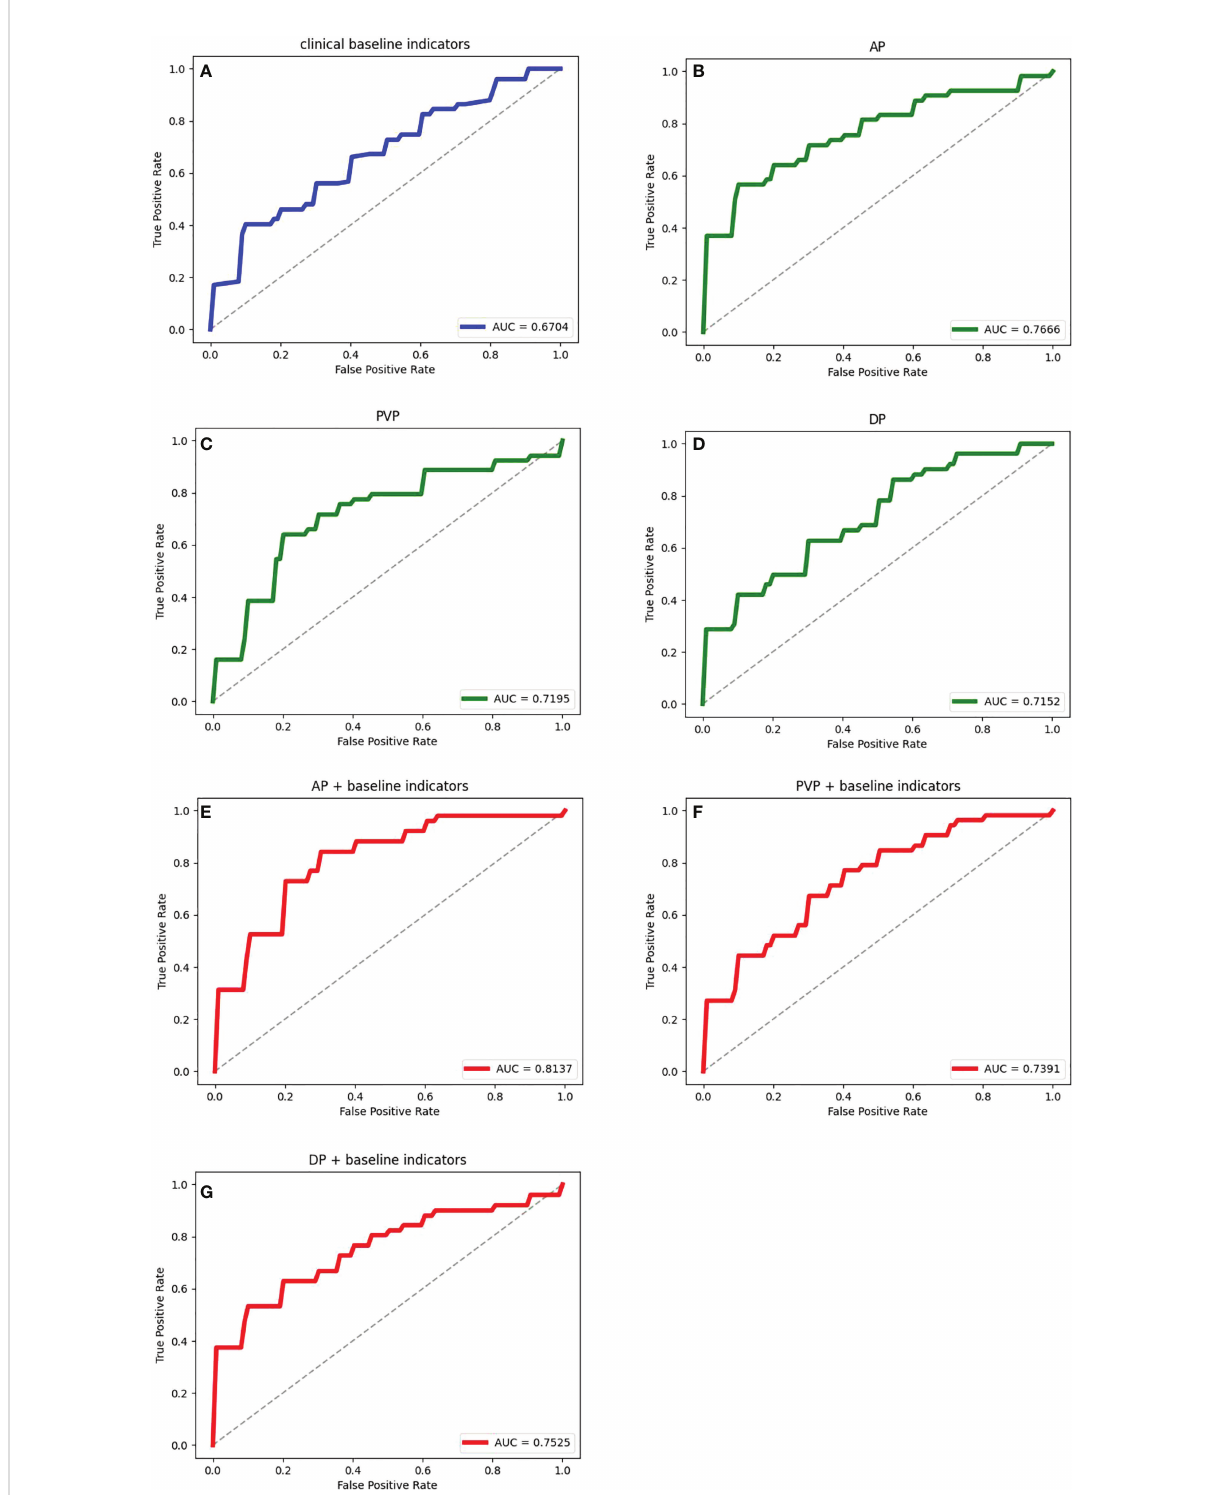
FIGURE 6 The ROC curves and the corresponding AUCs of the ensemble learning model with different feature representations. (A) is the result of inputting personal information and clinical indicators; (B – D) are the results of inputting radiomic features during AP, PVP and DP respectively; (E – G) are the results of inputting radiomics features during AP, PVP and DP combined with clinical data